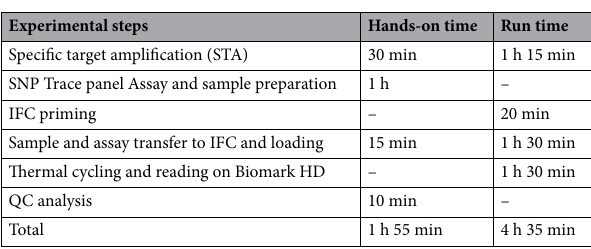
Table 1. Experimental steps for Fluidigm SNPtrace